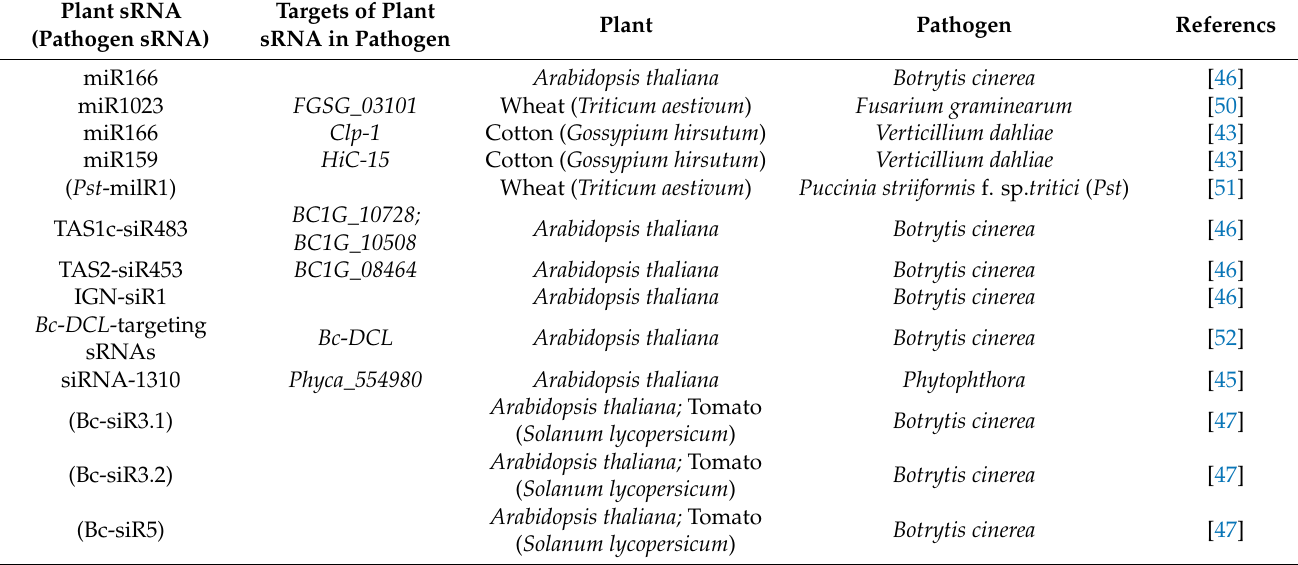
Table 1. Summary of disease-related cross-kingdom sRNAs acting in different plants and